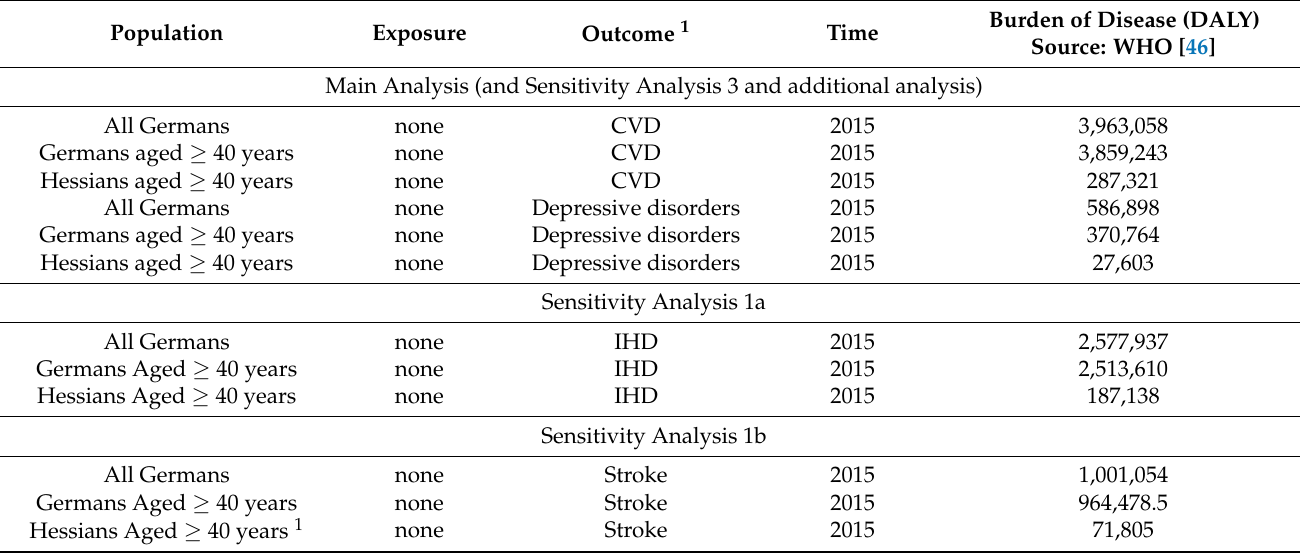
Table 2. The DALYs due to cardiovascular diseases and depressive disorders attributable to all risks in Germany and Hesse (people age ≥ 40 years) used for the various analyses. The shaded rows were used for the calculation of DALYs attributable to road-traffic noise. Population Exposure Outcome 1 Time